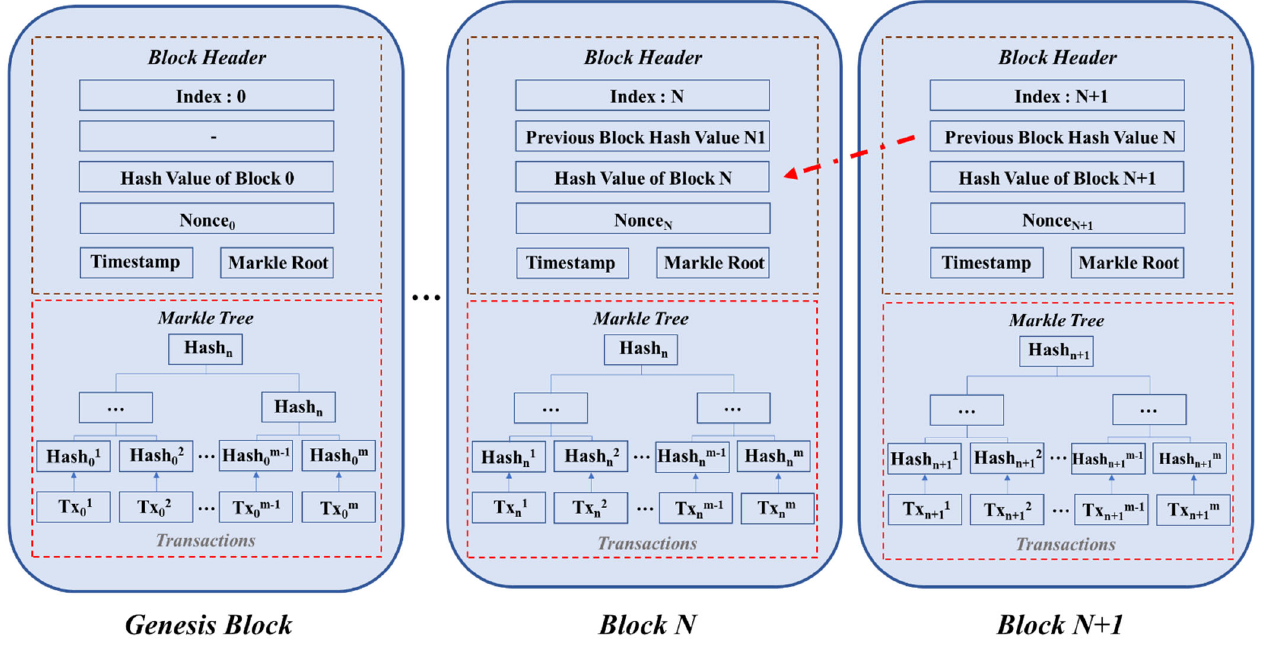
Figure 1. A Blockchain Architecture